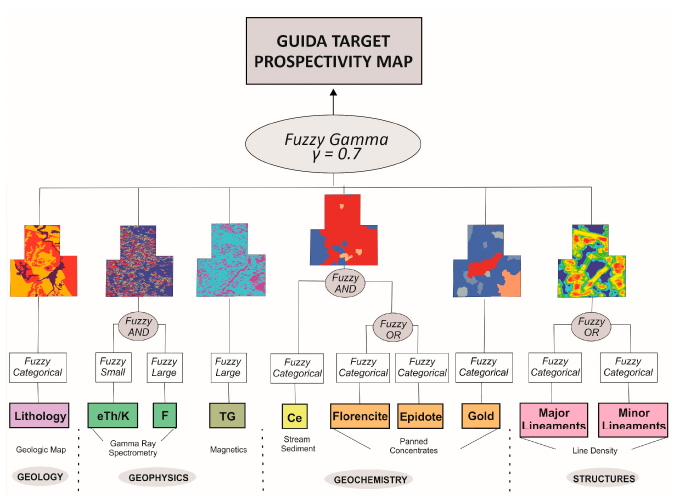
Figure 6. Flowchart detailing the main steps for Guida Target prospectivity modeling, including the fuzzy logic operators and pertinence functions.